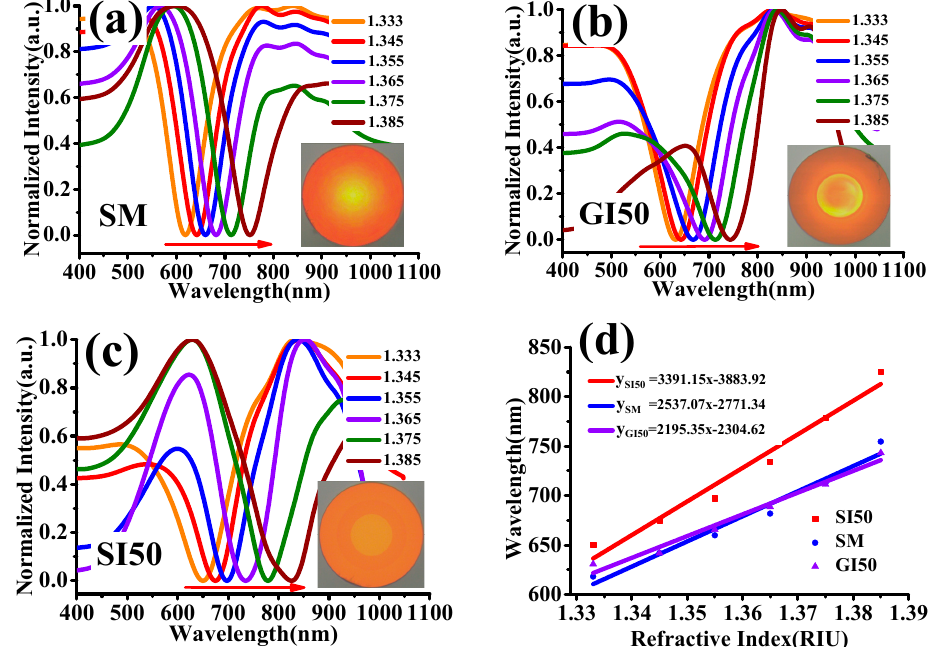
Figure 4. Refractive index sensing test results of different types of twisted fiber SPR probes: ( a ) single-mode twisted probe; ( b ) graded index multimode twisted probe; ( c ) step-index multimode twisted probe; ( d ) resonant wavelength versus refractive index curve.